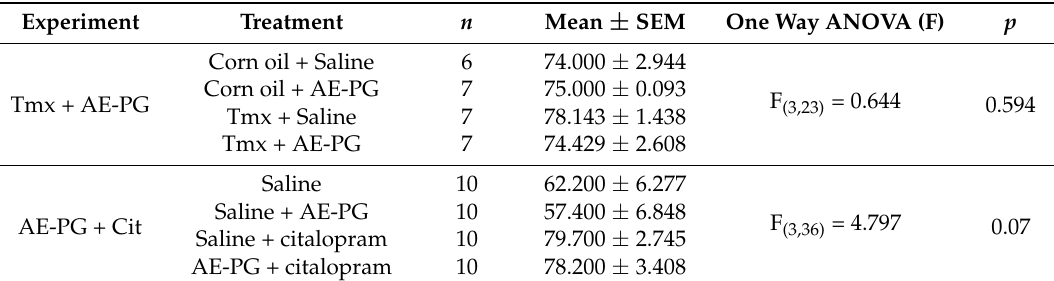
Table 2. Number of crossings in the open-field test with the chronic administration of Tmx + AE-PG and citalopram +